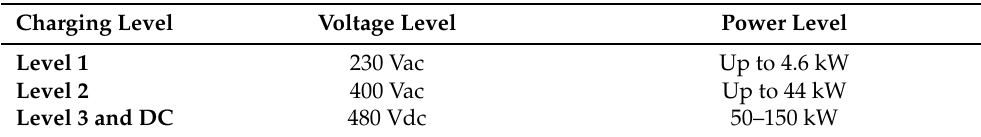
Table 2. EV Charging Level (EU Standards)